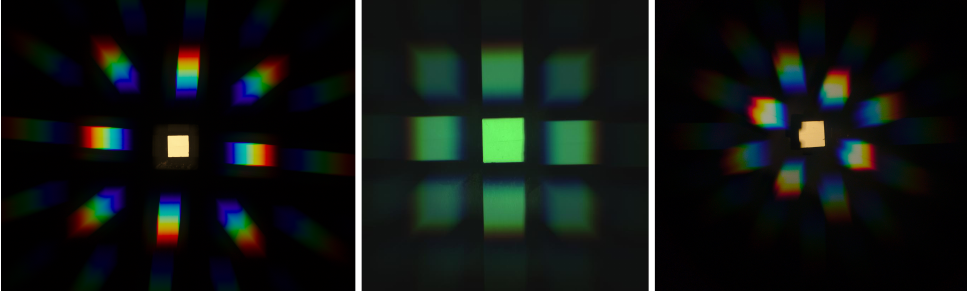
Figure 2. Diffraction images captured using three cameras: Canon M3, Raspberry Pi HQ camera, Samsung S10 main camera. The Raspberry Pi HQ image appears excessively green because it has not been corrected for white balance, which is mostly relevant for presentation purposes